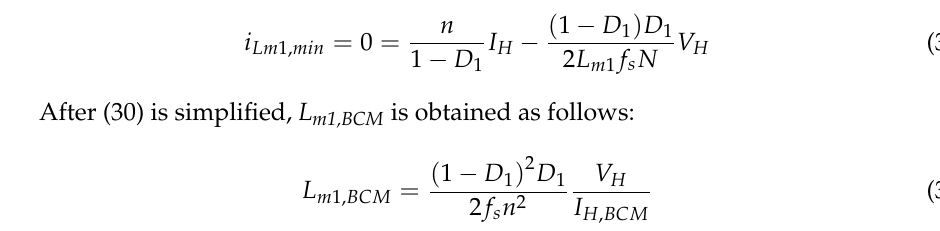
Figure 10. Lm 1, BCM in step-down mode.